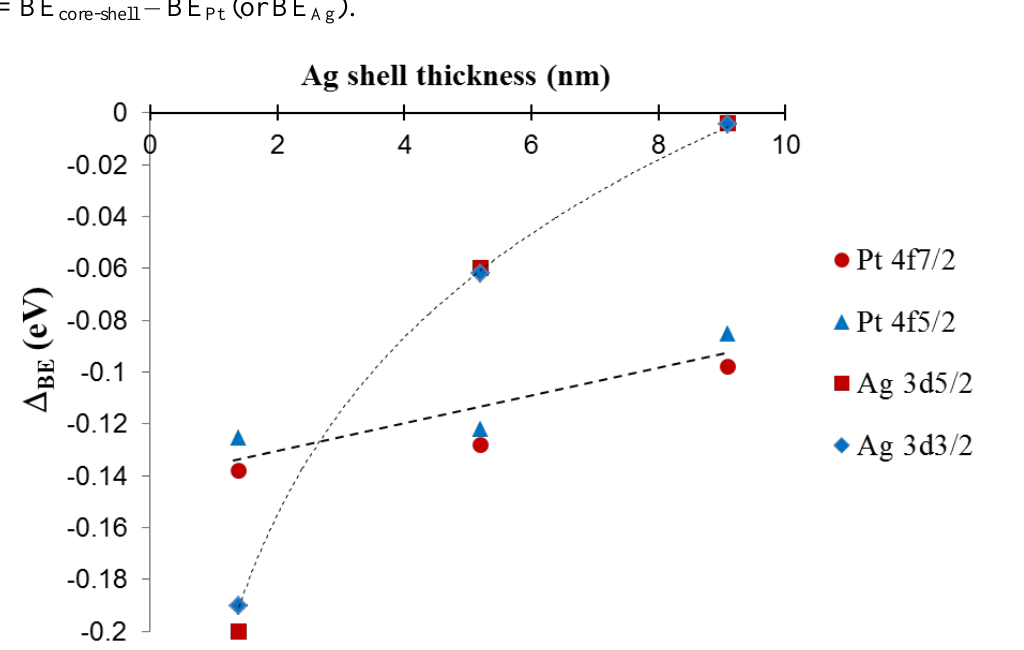
Figure 9. The Pt 4f and Ag 3d peak energy shift plotted as a function of silver shell thickness for Pt @Ag ( y = 1.3, 5.2, and 9.1 nm) NPs. The peak energy shift 39.8 y  = BE ‒ BE (or BE BE core-shell Pt Ag